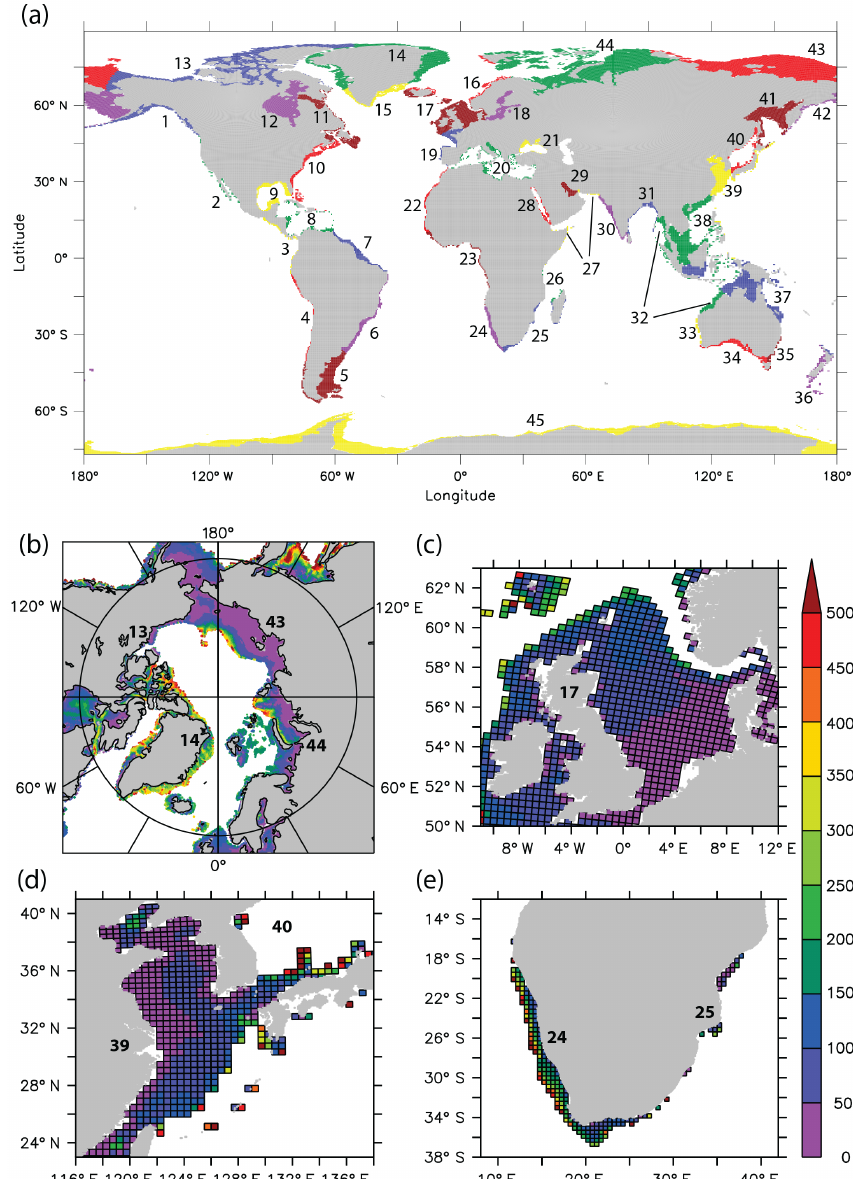
Figure 1. (a) Global segmentation of the coastal ocean following Laruelle et al. (2013) as regridded on the ORCA05 model grid. Colours distinguish limits between the MARCATS regions, numbers indicate regions defined in LA13. To perceive the spatial resolution of the ORCA05 configuration in the MARCATS context, we show zoomed-in images of bathymetry in four regions: (b) the Arctic polar margins, (c) the North Sea, (d) the Sea of Japan, the China Sea, and Kuroshio, and (e) south-western Africa and the Agulhas current. In the latter three panels, grid resolution is indicated by thin black